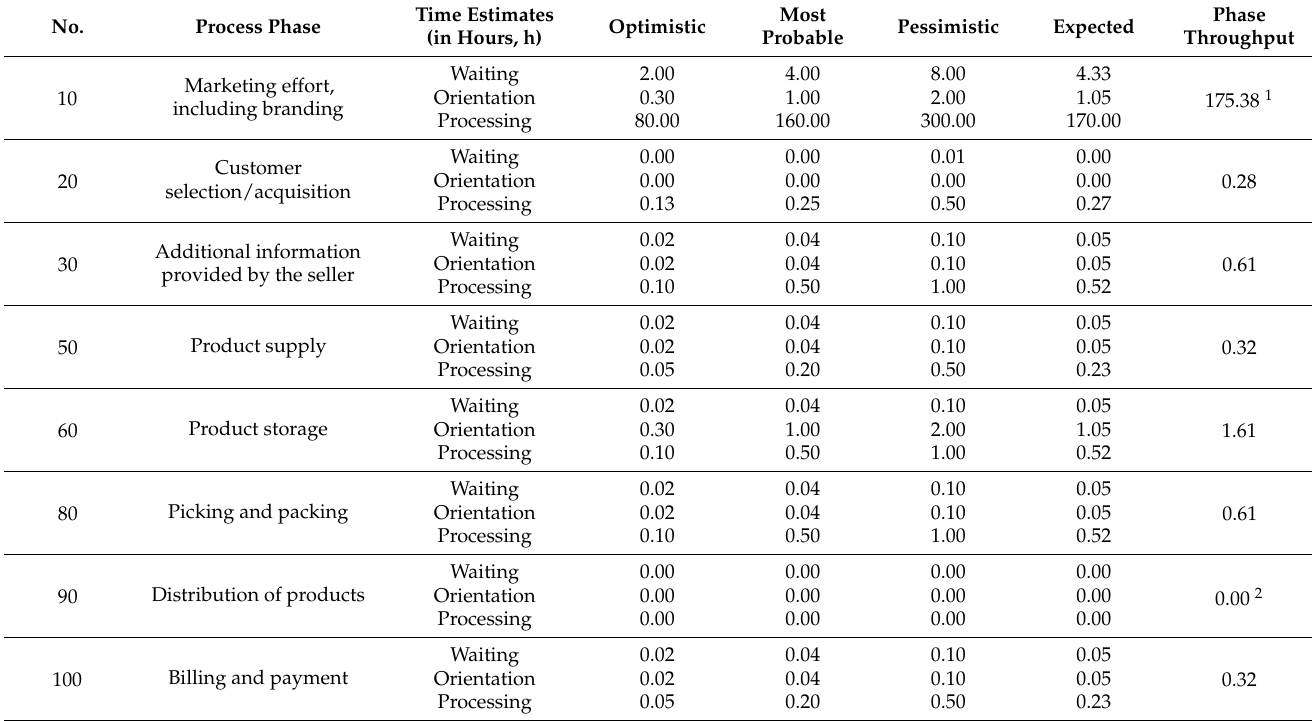
Table 7. Time estimates of the personal sales channel’s